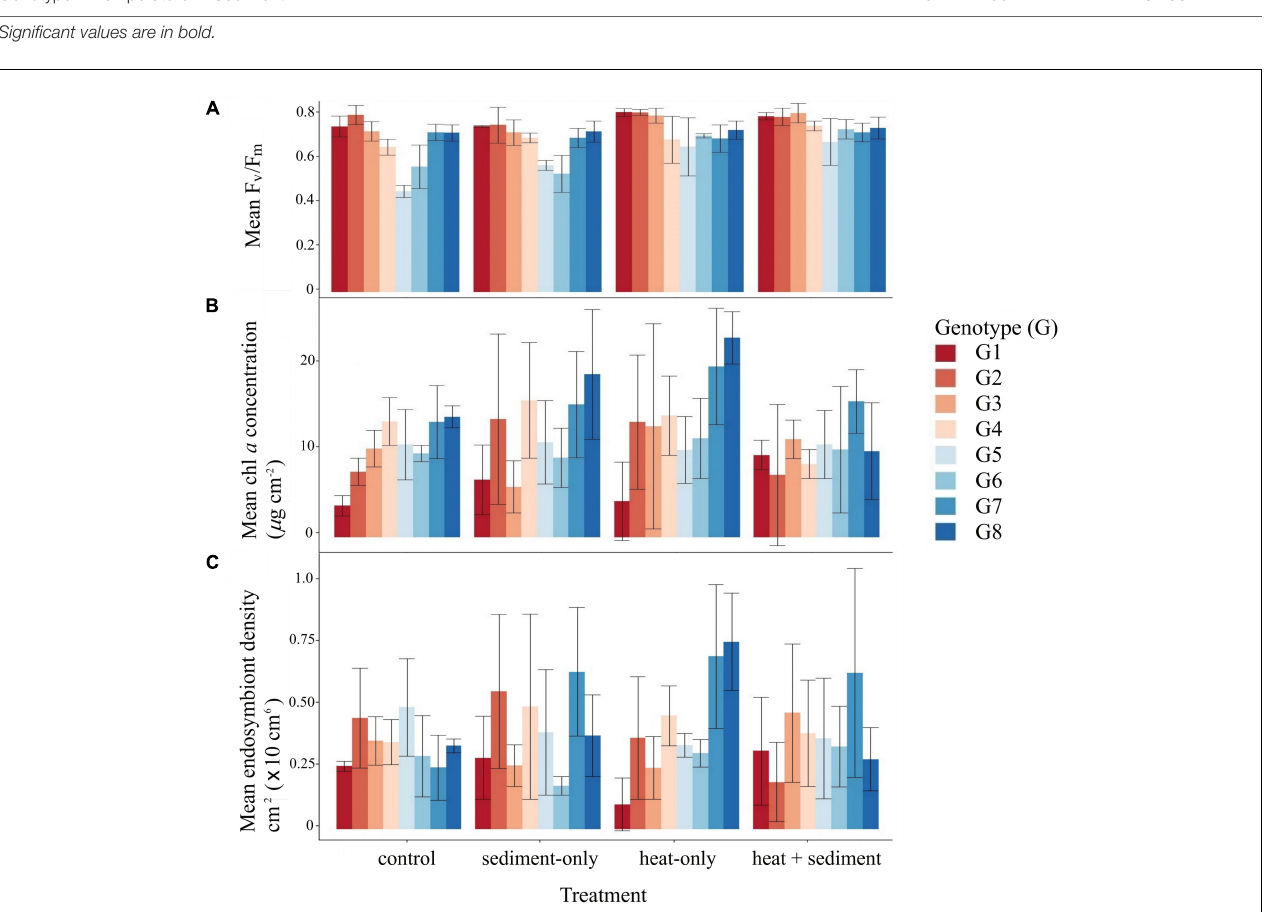
FIGURE 2 | Average levels of maximum quantum yield (F v /F m ) (A) , chl a concentration (B) and, symbiont density (C) for all genotypes and different treatments. Box plots show median values (solid horizontal line), interquartile range (box outline) and highest and lowest extremes (whiskers).